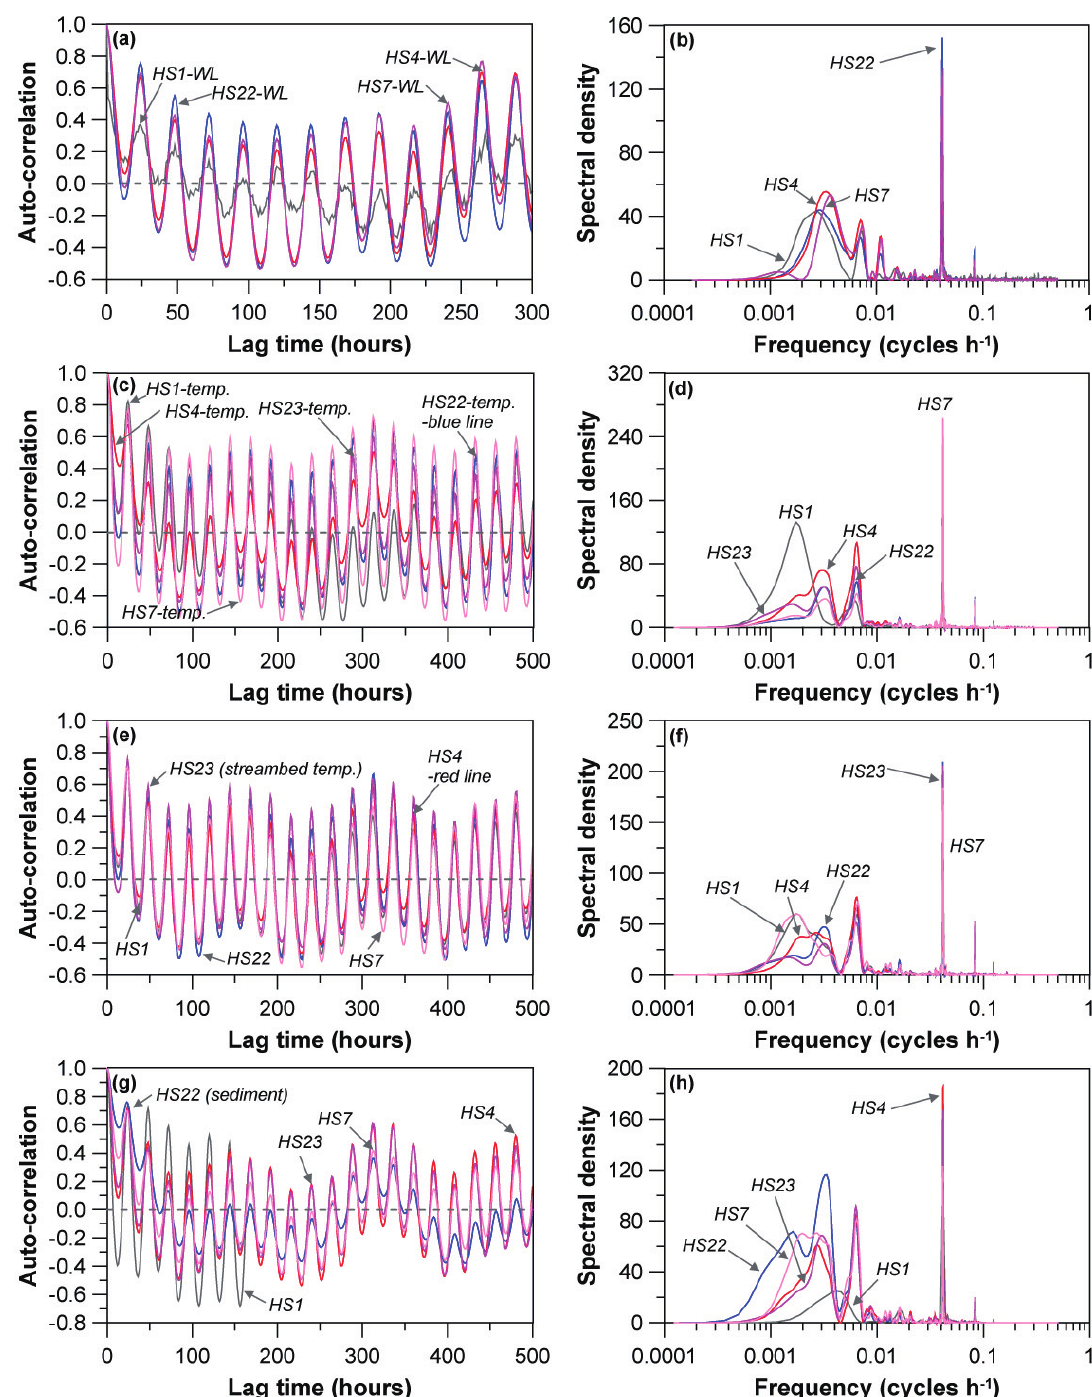
Figure 7. ( a ) Auto-correlation (truncation = 500 hours, except water level at 300 hours) and ( b ) spectral density functions for stream water level; ( c ) Auto-correlation (truncation = 500 hours, except water level at 300 hours) and ( d ) spectral density functions for water temperature; ( e ) Auto-correlation (truncation = 500 hours, except water level at 300 hours) and ( f ) spectral density functions for streambed temperature; ( g ) Auto-correlation (truncation = 500 hours, except water level at 300 hours) and ( h ) spectral density functions for and adjacent sediment temperature. The dotted lines represent that auto-correlation becomes a null